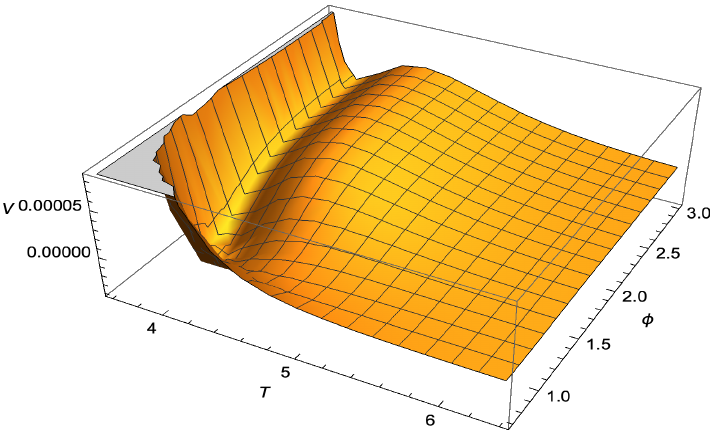
Figure 3 . A plot showing the inflationary region in which the potential is temporarily fixed at a minimum in the modulus τ direction while the inflaton ϕ slowly rolls. At the end of inflation the two fields run to their minimum at τ with τ 0 , ϕ 0 0 (cid:29) τ inf